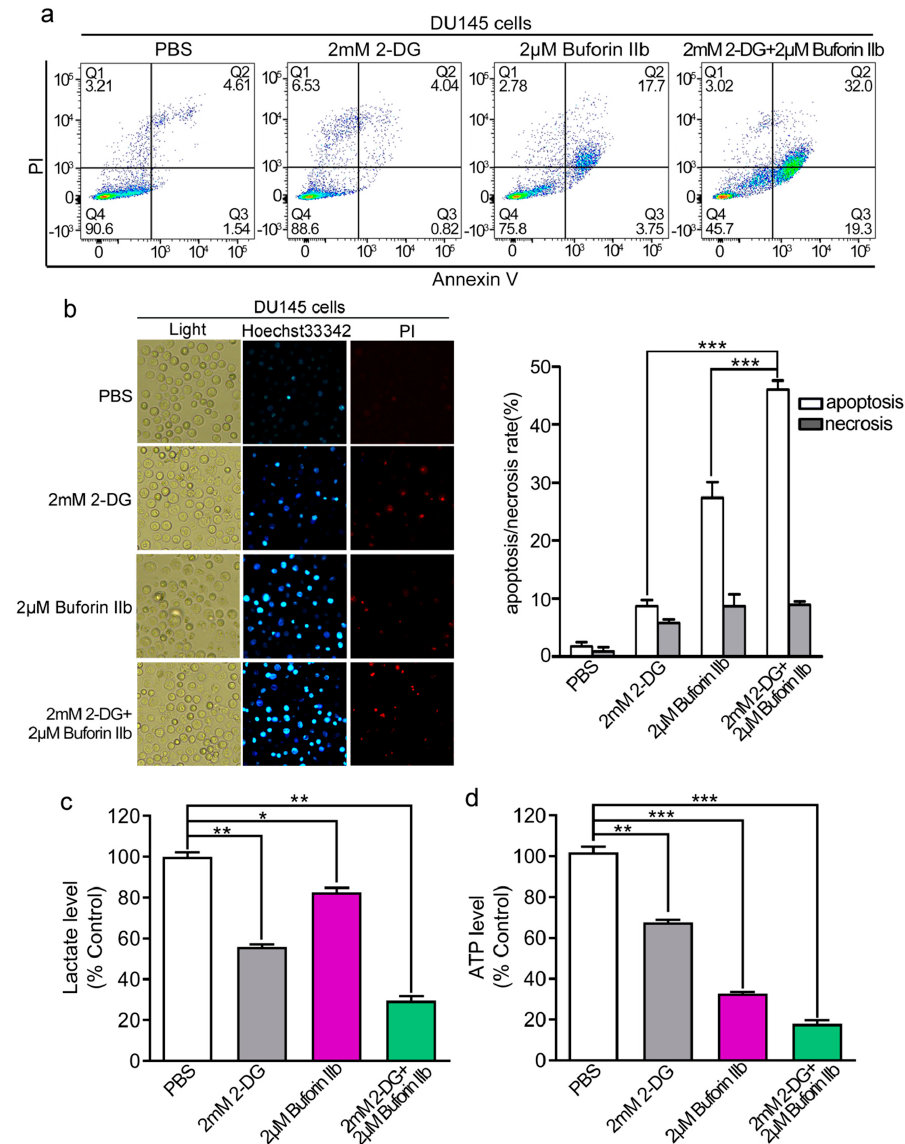
Figure 3. Apoptosis and metabolic levels in DU145 cells treated with buforin IIb or 2-DG alone or in combination. DU145 cells were treated with buforin IIb or 2-DG alone or in combination, stained with Annexin V-FITC/PI, and analyzed by flow cytometry ( a ) or stained by Hoechst 33342/PI and then observed by fluorescence microscopy ( b ). Lactate levels in the medium ( c ) and intracellular ATP levels ( d ) were measured after treatment with 2-DG alone for 24 h, buforin IIb alone for 12 h, or pretreatment with 2-DG for 12 h followed by buforin IIb for combination treatment for 12 h. * p < 0.05, ** p < 0.01, *** p < 0.001.